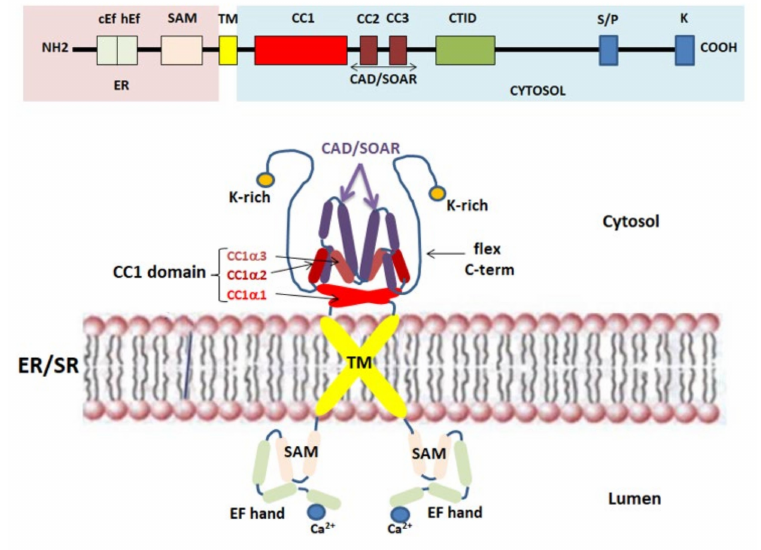
Figure 1. Schematic representation of the STIM1 structure in the resting state with the transmembrane (TM), N -and C -terminalregionsandthemostimportantdomainshighlighted. ER/SR—endoplasmic/sarcoplasmic reticulum; TM—transmembrane; SAM—sterile-motif domain; CC1 domain—conserved cytosolic coiled-coil domain 1; CAD/SOAR—CRAC activation domain/STIM1–Orai1 activating